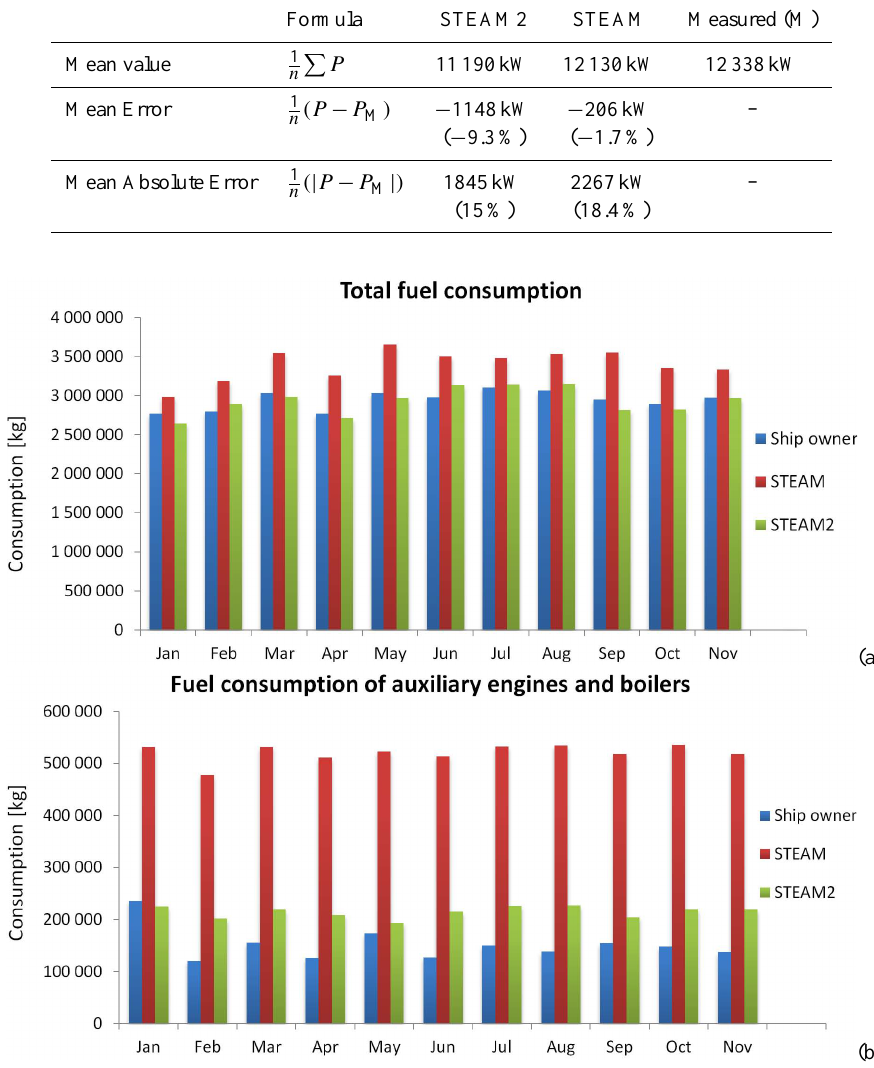
Fig. 8. (a)–(b) : the monthly average fuel consumption of a RoPax ship in 2007, as reported by the ship owner, and predicted by the two model versions. The total fuel consumption is presented in the upper panel, and the fuel consumption of auxiliary engines and boilers in the lower